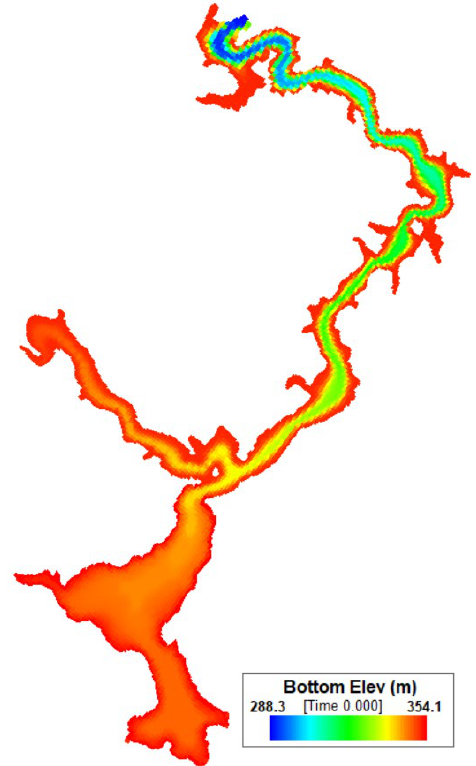
Figure 3. Bottom elevation for Jingpo Lake.